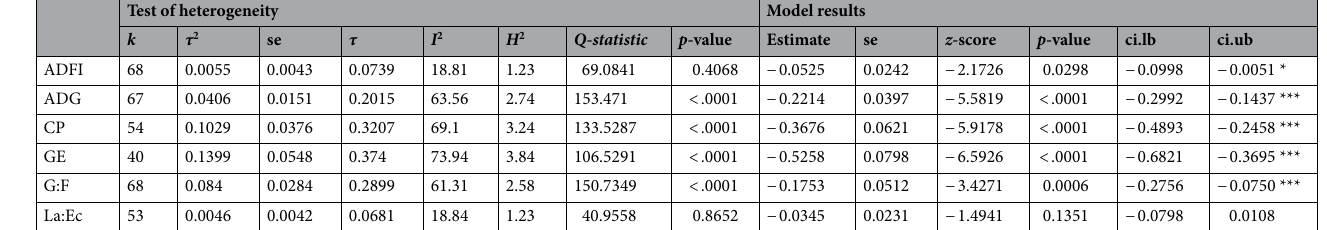
Table 4. Random-effects model with the τ 2 estimator as restricted maximum-likelihood estimator.